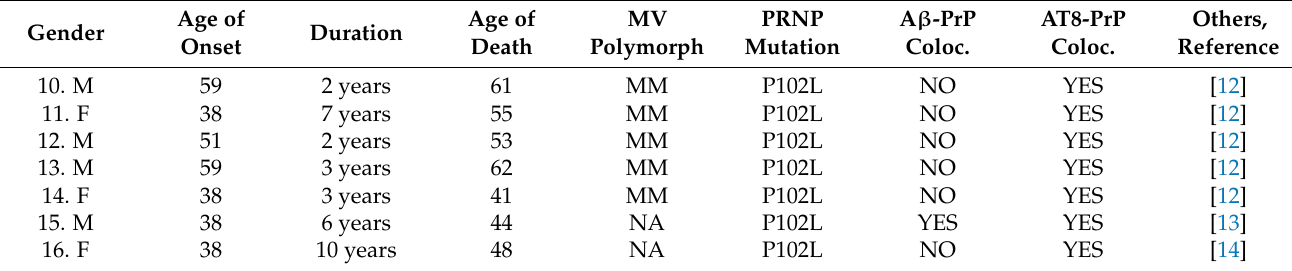
Table 2. Summary of GSS cases having the P102L mutation in PRNP gene described in the literature with information on amyloid-beta and hyperphosphorylated tau protein colocalization with pathological prion protein including all available details. (coloc. = colocalization).